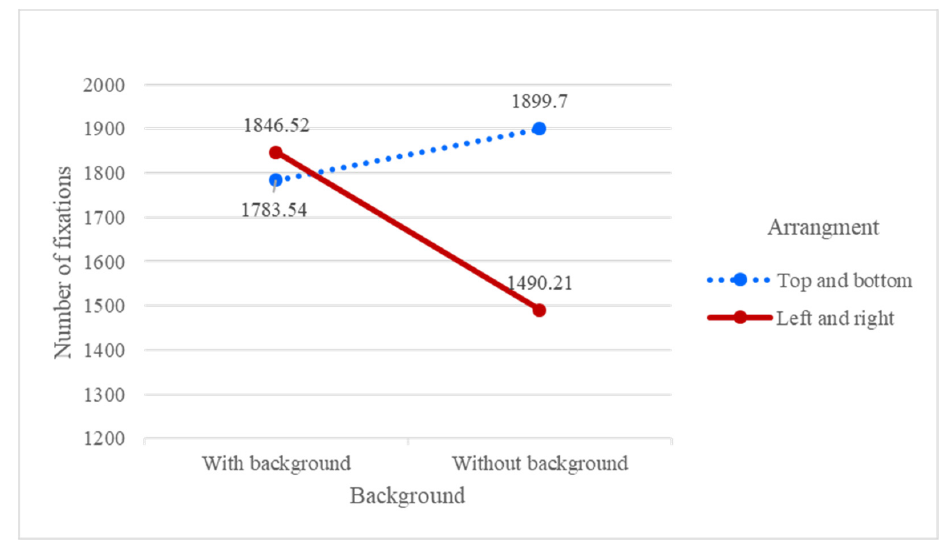
Figure 5. The interaction between background and arrangement for the number of fixations.